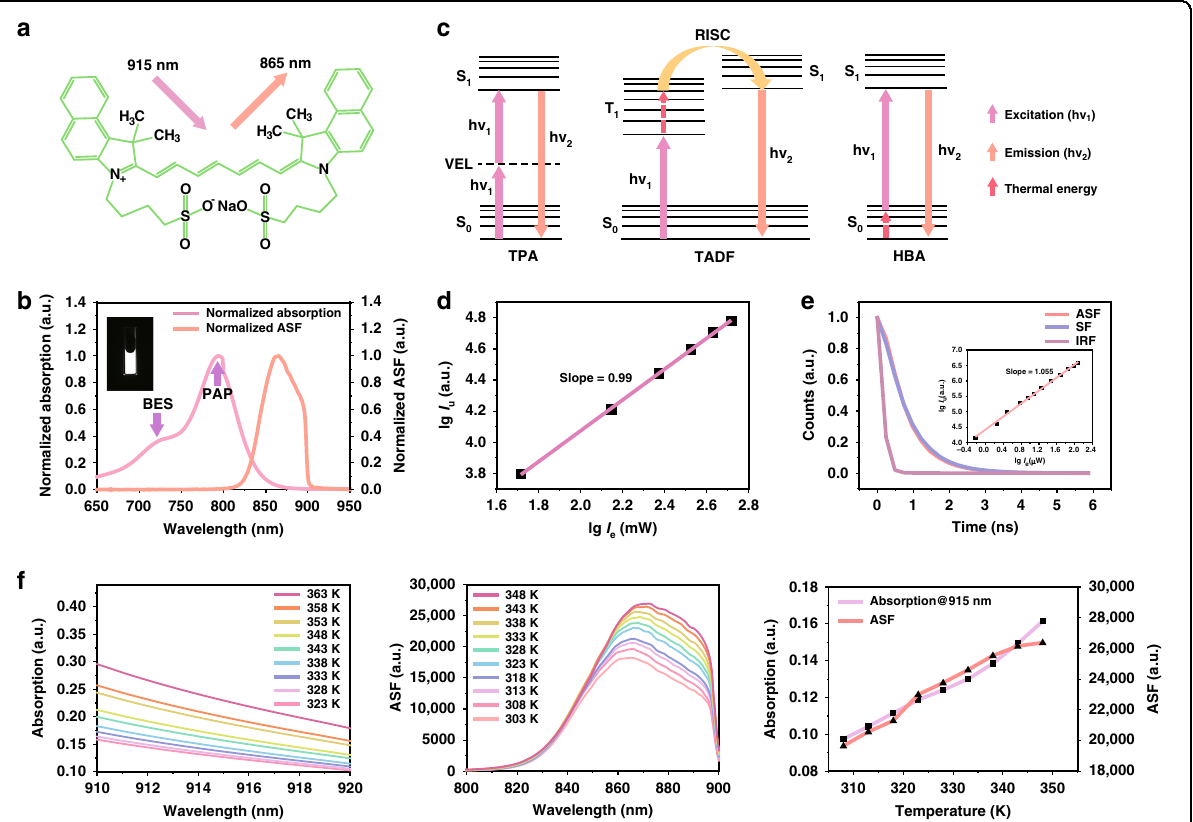
Fig. 1 ASF characterization of ICG in DMSO. a The molecular structure of ICG. b The normalized absorption and ASF ( <900 nm) spectra of ICG. Insert: the ASF image of ICG (0.1 mg mL − 1 ), excitation: 915 nm CW laser (26.8 mW cm − 2 ), fl uorescence collection range: 800 – 900 nm, exposure time: 25 ms. c Schematic illustration of different ASF processes in organic molecules. d A logarithmic plot showing the power dependence of ICG ’ s ASF at 865 nm on the excitation light, 915 nm CW laser. e Lifetimes of ASF and SF of ICG (2 mg mL − 1 ). Excitation: 915 nm fs pulsed laser for ASF, 750 nm fs pulsed laser for SF; fl uorescence collection range: 850 – 900 nm. Insert: the power dependence of ICG ’ s ASF intensity on the 915 nm fs pulsed laser intensity. f Temperature dependence of ICG ’ s absorption spectra (910 – 920 nm) and ASF spectra (800 – 900 nm) excited by the 915 nm CW laser. The temperature dependence of ICG ’ s absorption at 915 nm, as well as the ASF intensity excited by the CW laser at this wavelength, is also plotted. Abbreviations: PAP principal absorption peak, BES blue edge shoulder, TPA two-photon absorption, VEL virtual energy level, RISC reverse intersystem crossing, IRF instrument response